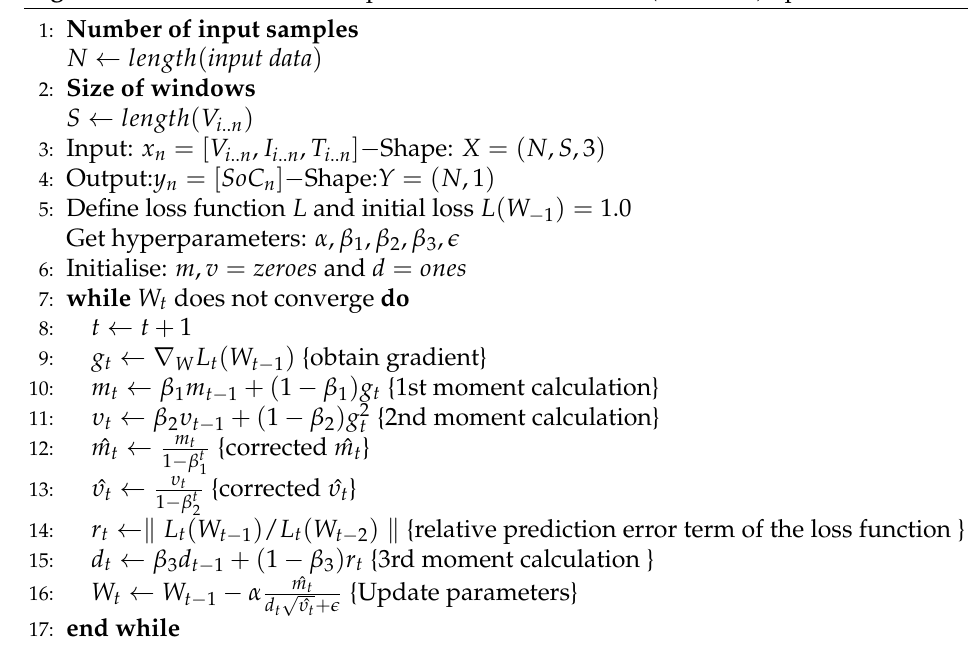
Algorithm 3 Robust online adaptive moment estimation (RoAdam)